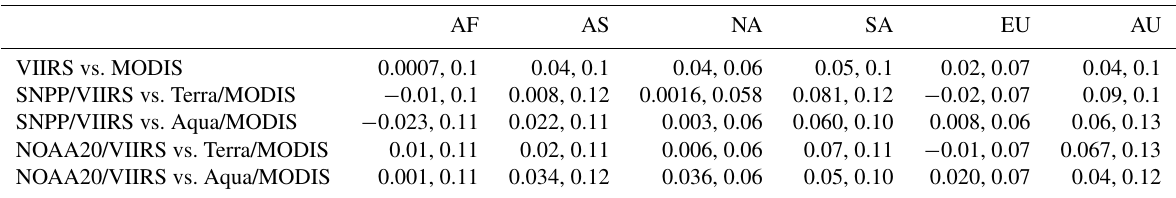
Figure 10. Global maps of temporal mean AOD from Terra and Aqua/MODIS as well as NOAA20 and SNPP/VIIRS for the MAM (2020) period over land. Table 5. Quantification of AOD differences between instruments over the land regional domains (defined in Table 3) for the DJF period. Each cell gives the MD followed by the